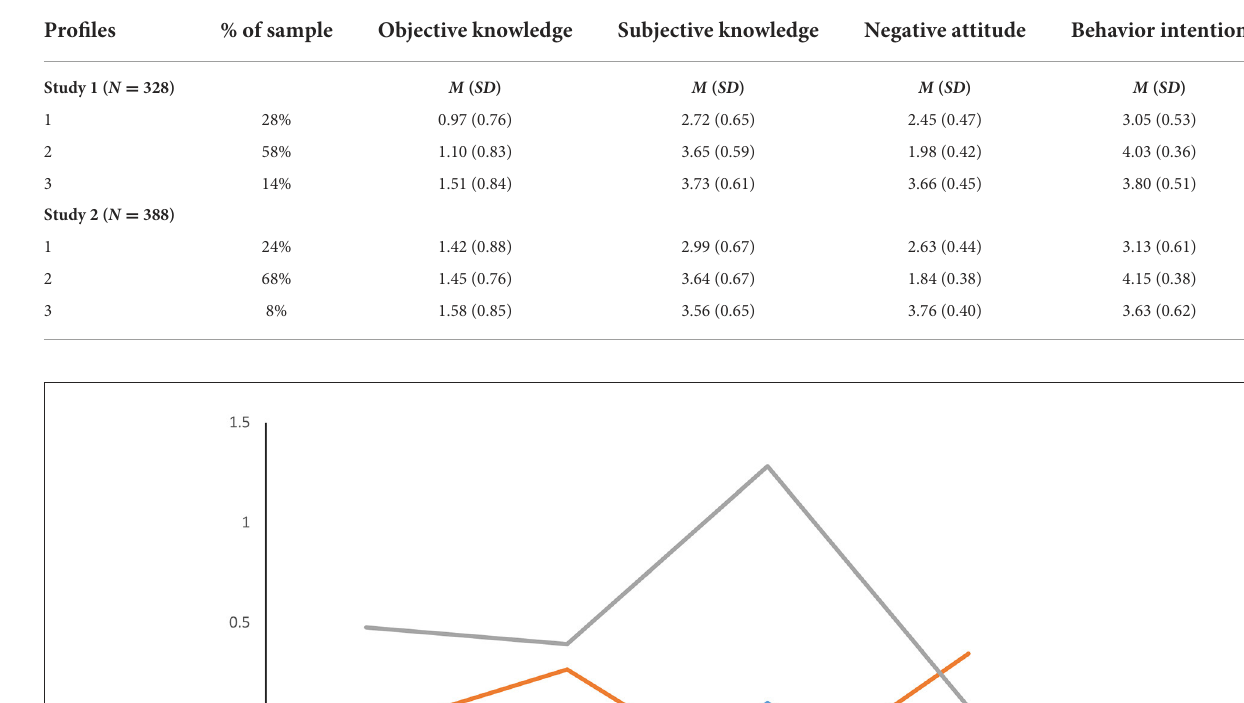
TABLE 4 Descriptive information of the retained profiles in study 1 and study 2.